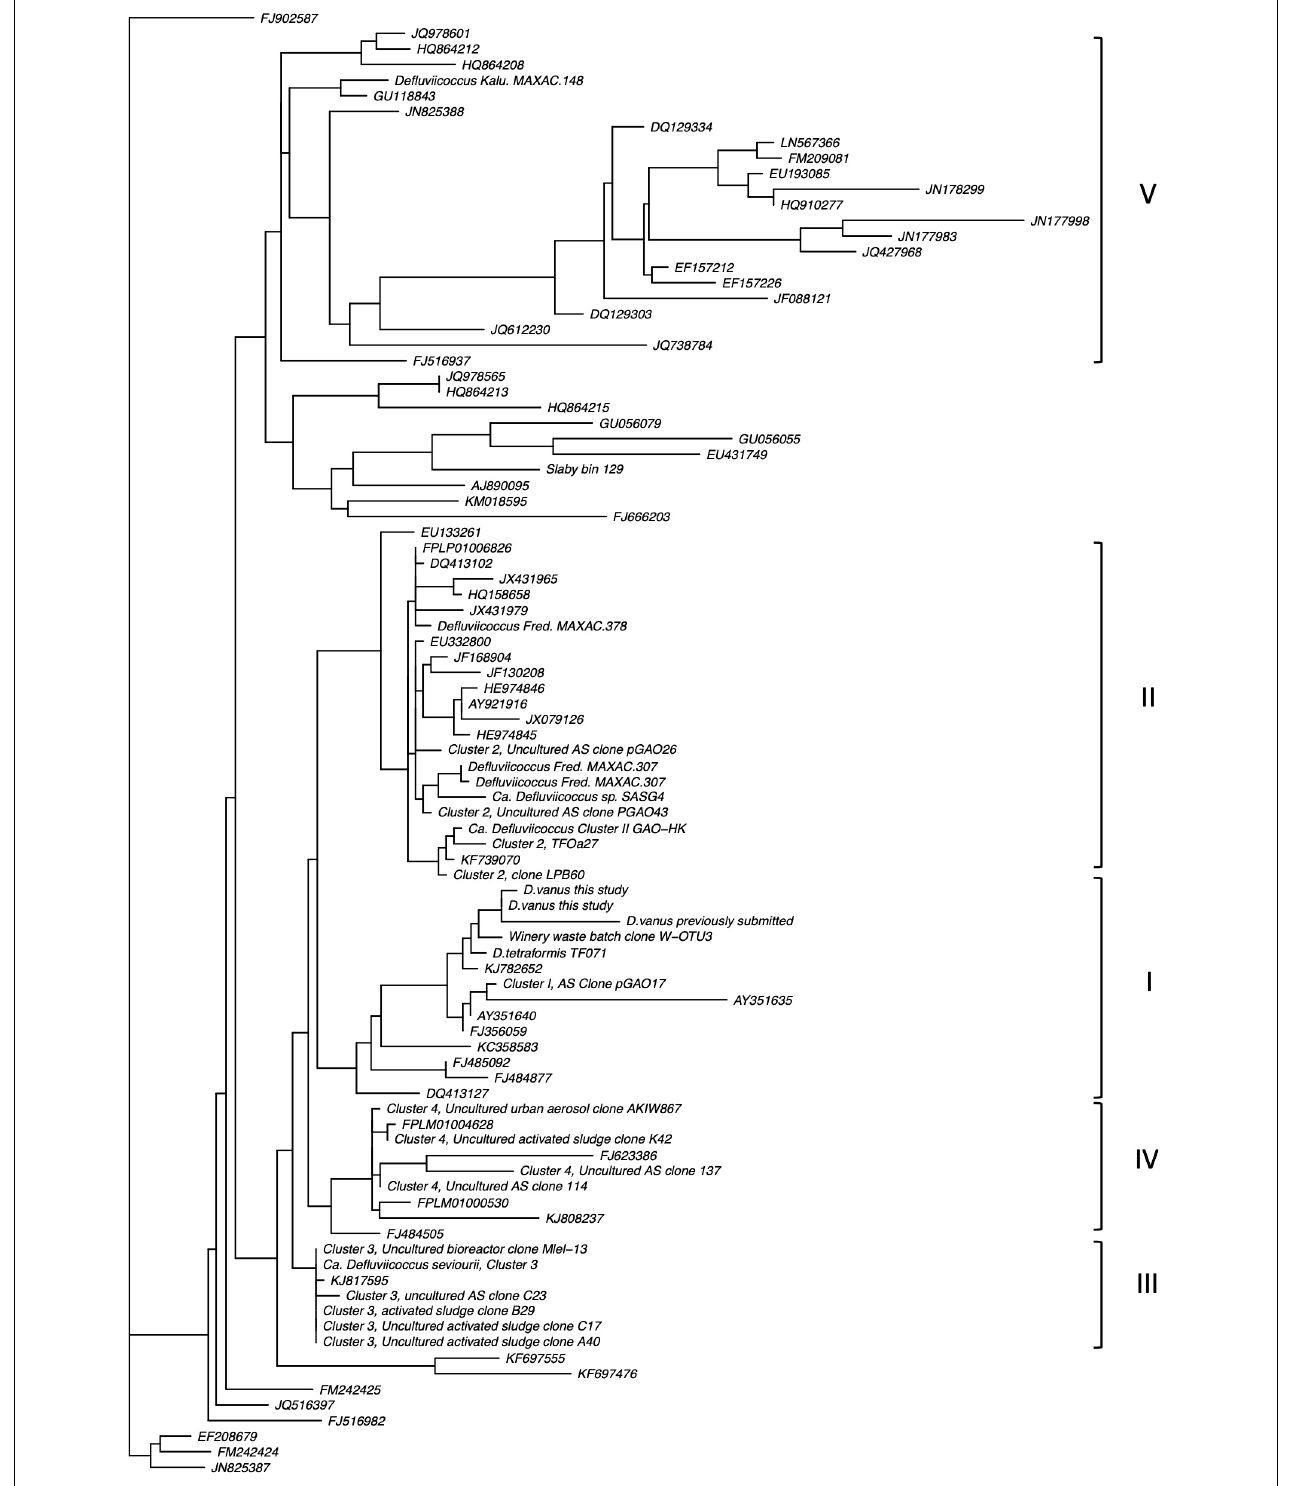
FIGURE 3 | Ribosomal SSU-rRNA gene phylogram showing clusters containing members of the genus Defluviicoccus . Note the recapitulation of previously defined Cluster groups (I–IV) as well as evidence of a new cluster (V) associated typified by 16S rRNA sequences from the sample from Kalundborg WWTP (for further details, see Section “Materials and Methods: Comparative Analysis of 16S-SSU rRNA Genes”).